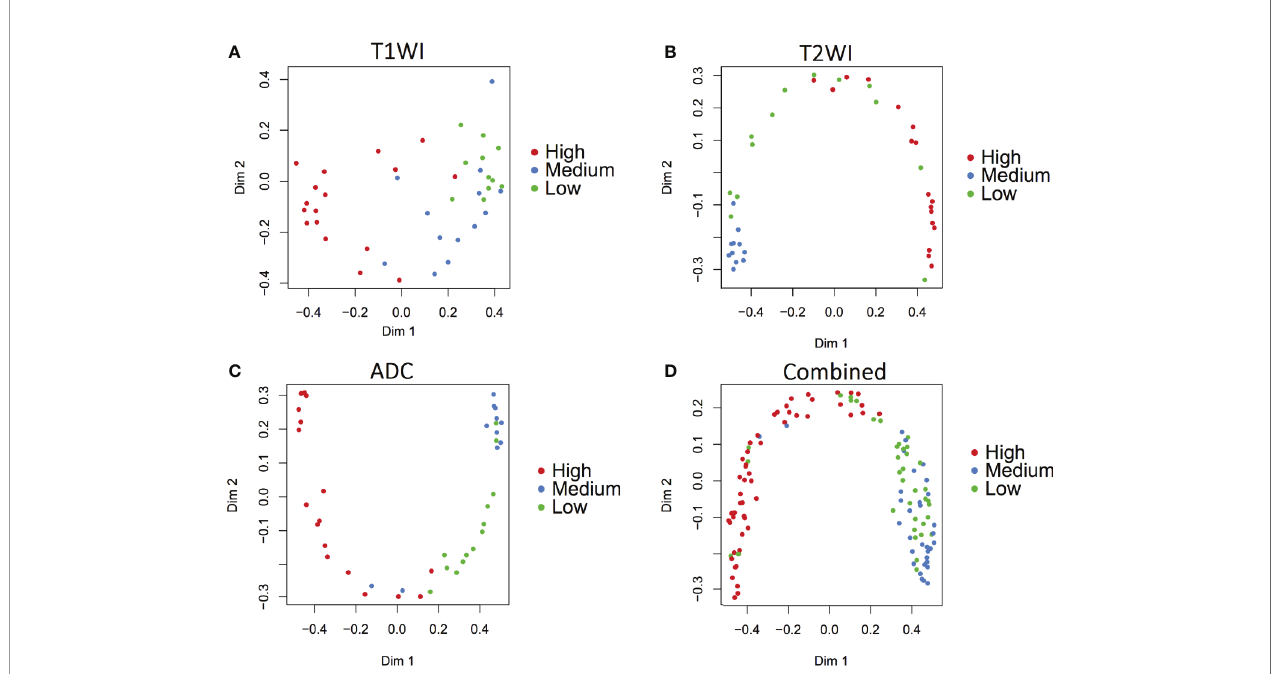
FIGURE 4 | Discriminant function analysis based on radiomics features extracted from three MRI sequences for the GISTs risk classi fi cation. (A) T1WI, 61.0% of the three originally grouped cases (three GISTs risk classi fi cation) were correctly classi fi ed; (B) T2WI, 70.7% of the three originally grouped cases (three GISTs risk classi fi cation) were correctly classi fi ed; (C) ADC, 83.3% of the three originally grouped cases (three GISTs risk classi fi cation) were correctly classi fi ed; (D) combined three MR sequences, 78.9% of the three originally grouped cases (three GISTs risk classi fi cation) were correctly classi fi